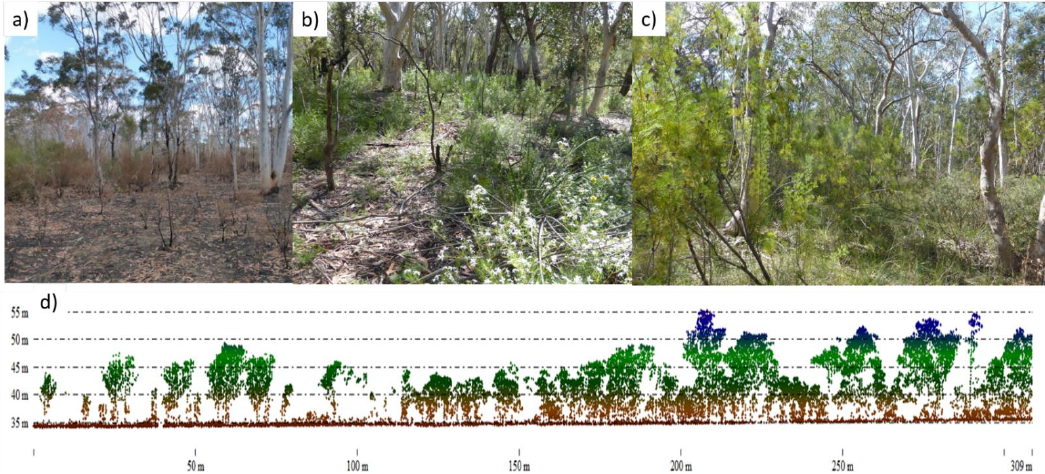
Figure 4. Examples of Scribbly Gum Woodland recovery from fire: ( a ) six weeks after fire; ( b ) one year after fire; ( c ) 14 years after fire; ( d ) lidar-derived canopy profile transect through SGW one year since fire (left) to eight years since fire (right) (y-axis scale indicates height above sea level).